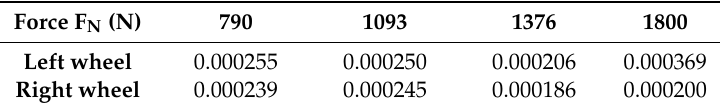
Table 2. Coe ffi cients of variation in individual measurement series. Table 2. Coefficients of variation in individual measurement series.